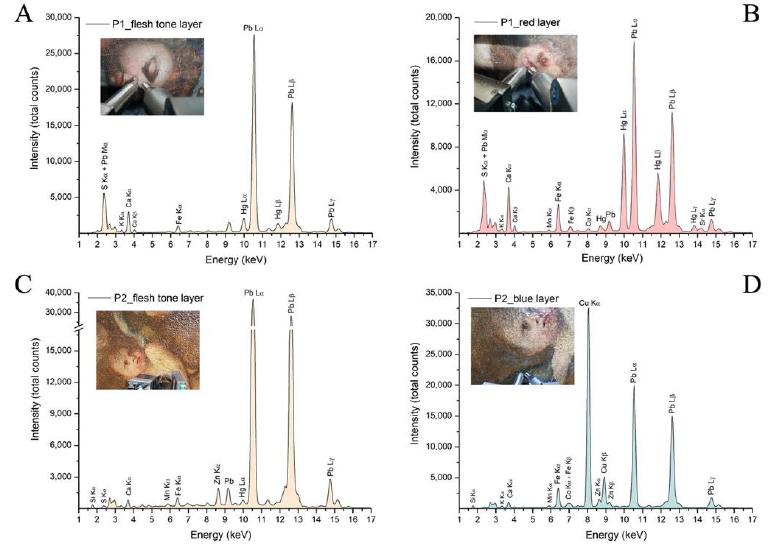
Figure 5. XRF spectra of Painting 1 ( A , B ) and Painting 2 ( C , D ). It is important to note that the measurements refer to original areas; however, in the case of Painting 2, it was not possible to avoid thin retouching along the craquelure lines, which resulted in the presence of minimal zinc counts in the XRF spectra.